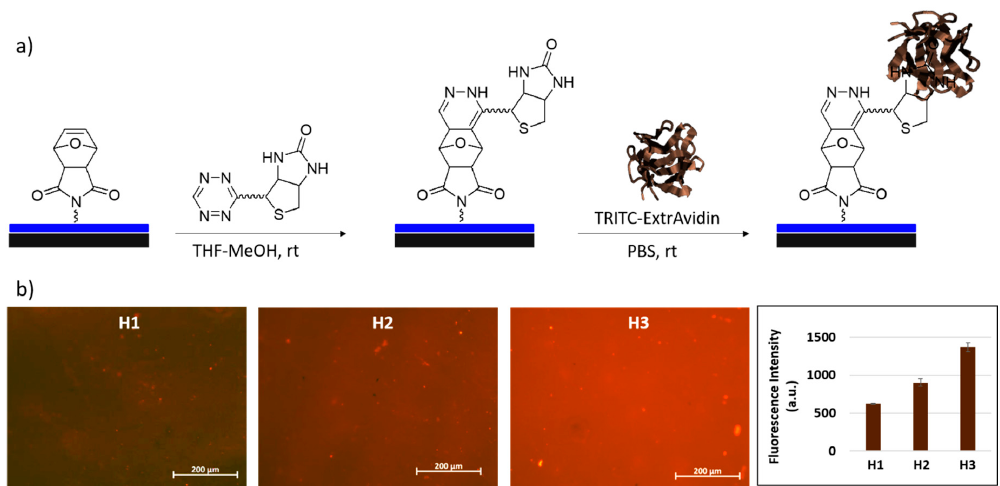
Figure 6. ( a ) Scheme of conjugation of oxanorbornene containing hydrogels with biotin-benzyl-tetrazine and following Tritc-ExtrAvidin immobilization; ( b ) fluorescence microscope images of Tritc-ExtrAvidin immobilized hydrogels and relative fluorescence intensity graph.